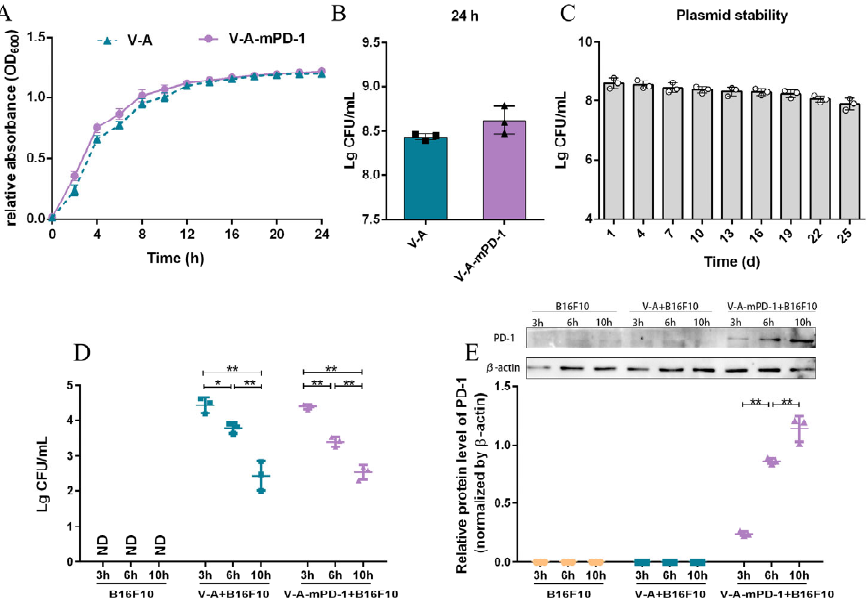
Figure 1. Evaluation of V-A-mPD-1 in vitro. ( A ) Growth curves of V-A and V-A-mPD-1. ( B ) The number of viable bacteria corresponding to 24 h incubation with V-A and V-A-mPD-1. ( C ) Plasmid stability test of V-A-mPD-1. ( D ) The quantity of the living bacteria in the B16F10 group, V-A+B16F10 group and V-A-mPD-1+B16F10 group at 3 h, 6 h and 10 h. ( E ) The expression levels of the mPD-1 protein in the B16F10 group, V-A+B16F10 group and V-A-mPD-1+B16F10 group were detected by Western blotting at 3 h, 6 h, and 10 h. V-A, VNP20009-Abvec-Ig κ ; V-A-mPD-1, VNP20009-Abvec-Ig κ - mPD-1. Two-tailed t-test for A and B, one-way ANOVA ( C ) or two-way ANOVA ( D , E ) and Tukey’s multiple comparison. Values are presented as means ± SD ( n = 3). * p < 0.05; ** p <